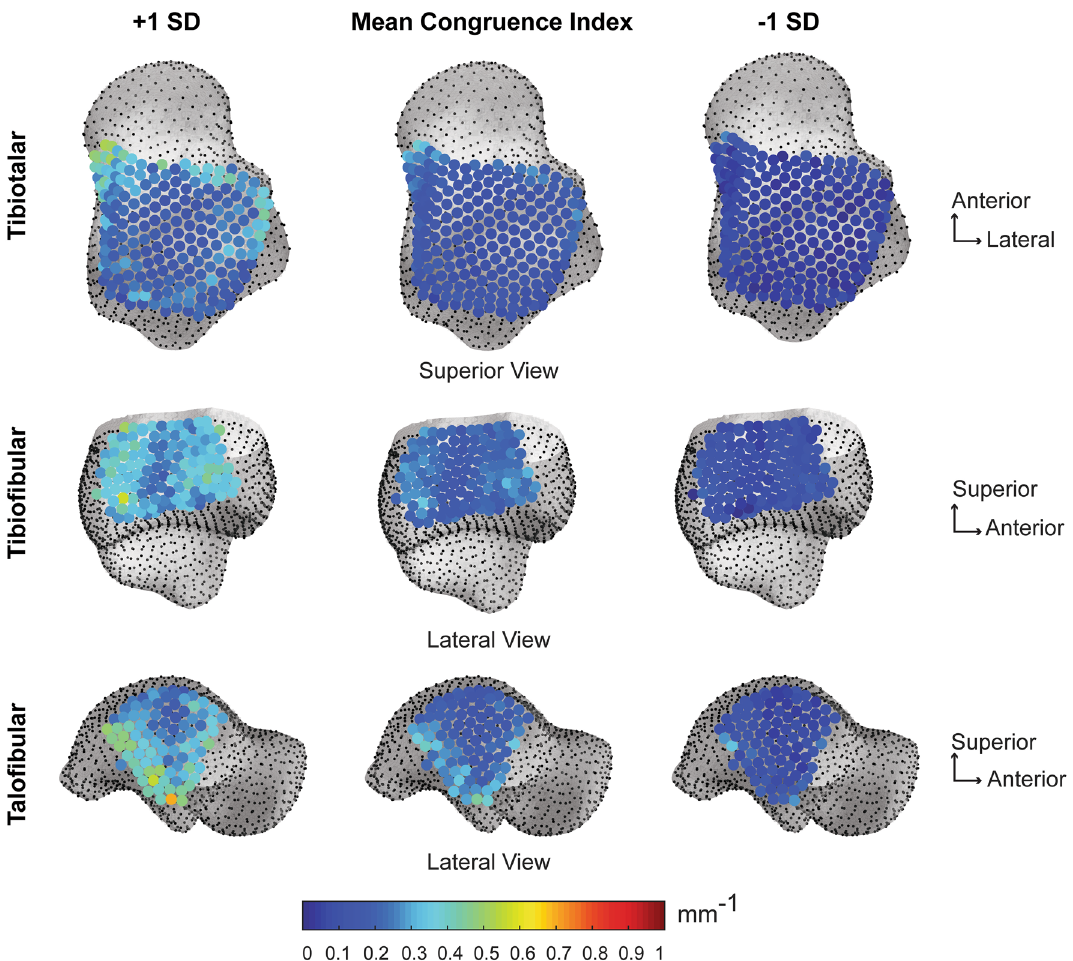
Figure 6. Average joint congruence index with ± 1 standard deviation (SD) for the tibiotalar, tibiofibular and talofibular articular regions. Results are visualized on the mean shape correspondence particles. Congruence index rated with a starting value of 0 mm -1 , with 0 demonstrating perfect